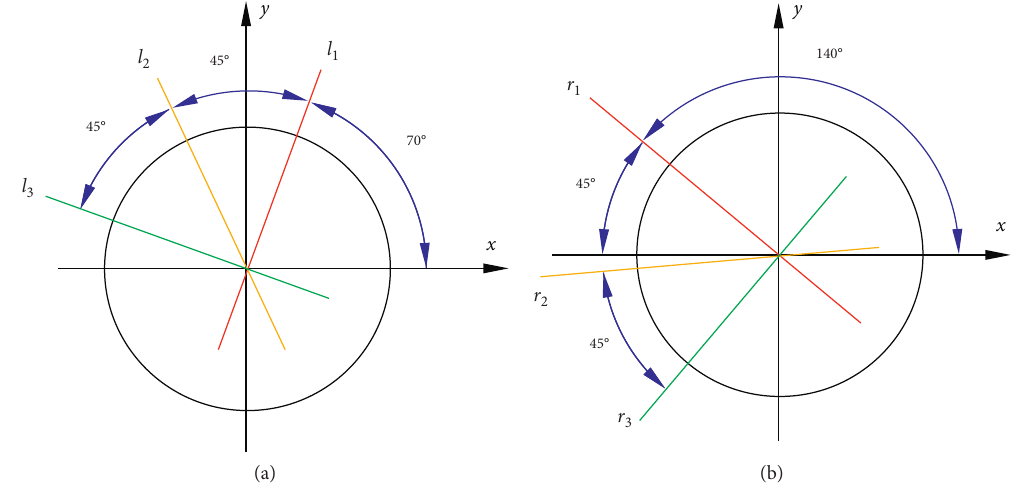
Figure 15: Installation angles of strain flowers on both sides of the fault: (a) left side and (b) right